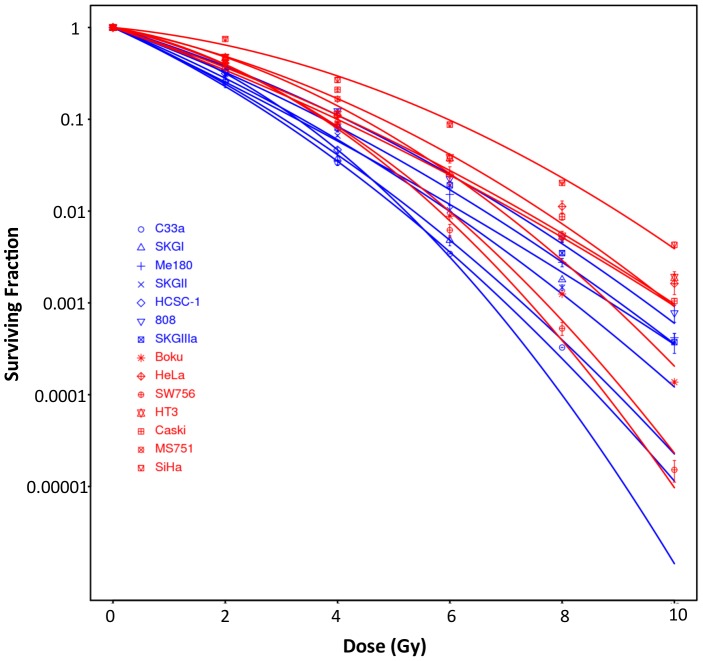
Radiobiological characterisation of cervix carcinoma cell lines.
A) Radiation survival curves showing surviving fraction (log10) (y-axis) following irradiation with 2, 4, 6, 8 and 10 Gy for 14 cervix cancer cell lines. Data points are the mean and standard error of 2–3 independent experiments (3–6 replicates per experiment). Data-points are fitted with the linear quadratic equation and coloured by below (blue) or above (red) the median SF2.